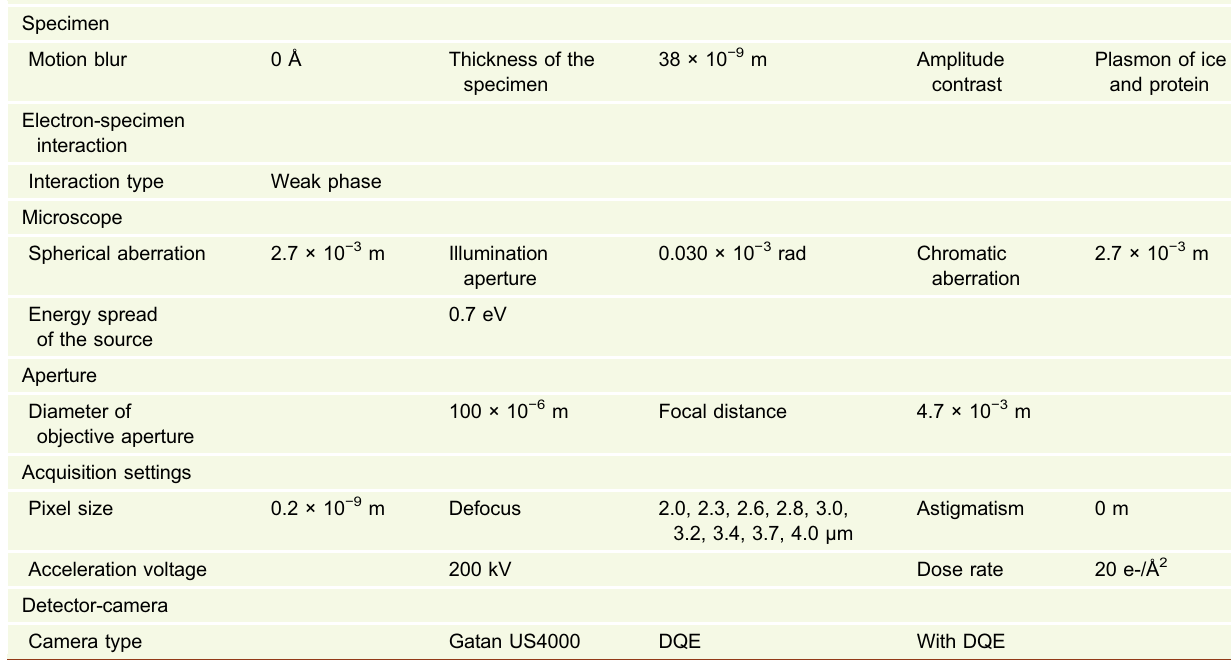
Table 3. All the physical parameters used in InSilicoTEM to generate a simulated dataset